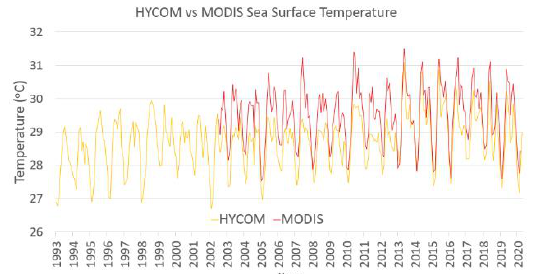
Figure 7. Decomposition of salinity in Busuanga from Figure 5. Comparison of sea surface temperature data from MODIS and HYCOM